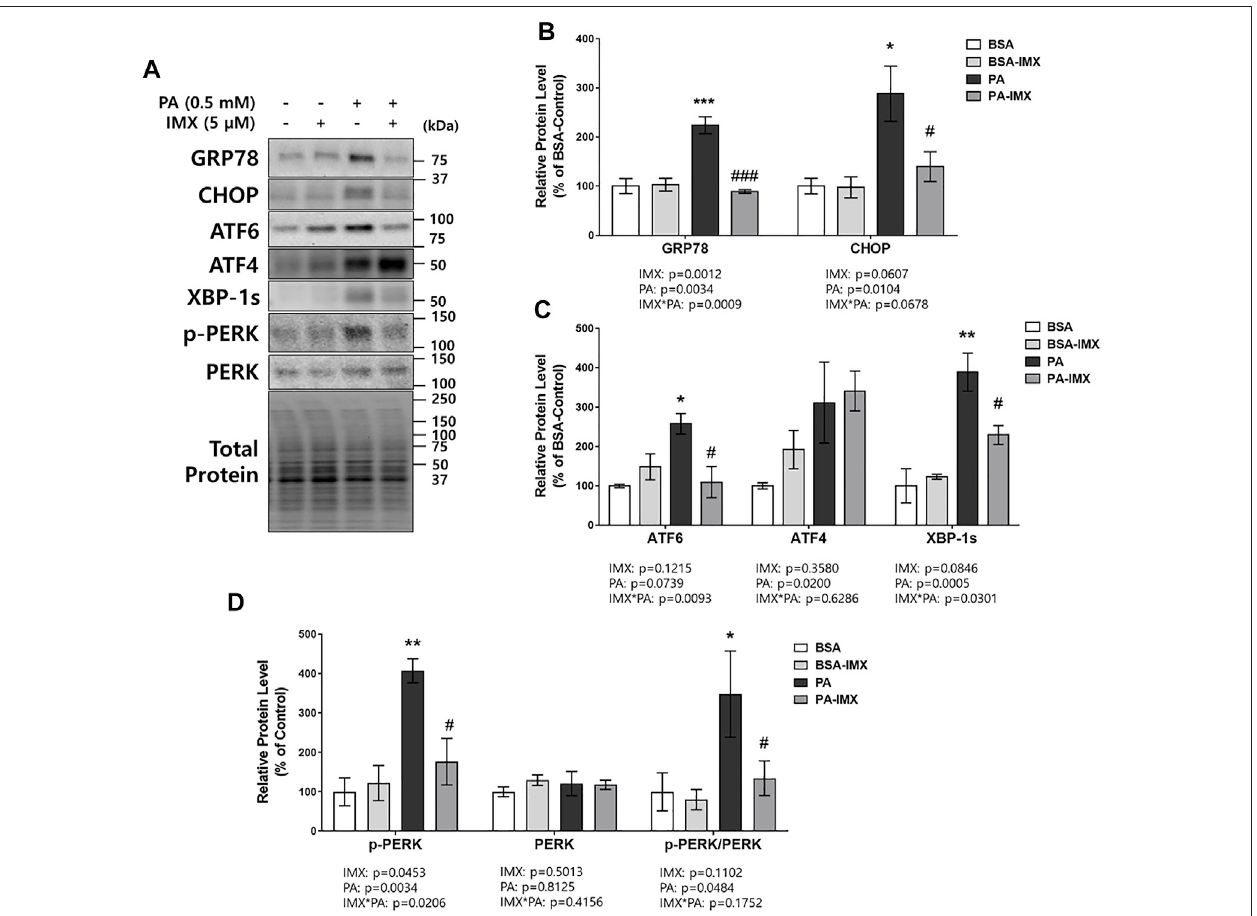
FIGURE 2 | Effect of imoxin on protein levels of ER stress-related markers stimulated by palmitate in C2C12 myotubes. The cells were treated with imoxin (IMX) at 5 μ M with/without 0.5 mM palmitate (PA) for 24 h. Protein level of each biomarker was measured by western blot. (A) Representative band images and (B – D) quanti fi cation data are shown. Values are presented as mean ± SEM (N = 3). Main effects and interactions were analyzed by two-way ANOVA (IMX x PA), followed by Tukey ’ s post-hoc test: * p < 0.05, ** p < 0.01 and *** p < 0.001 compared with the BSA-control group; # p < 0.05 and ### p < 0.001 compared with the PA only